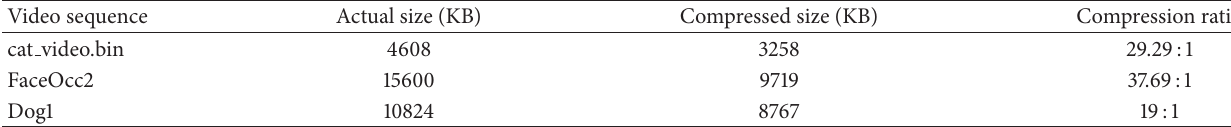
Table 1: Compression ratio of proposed method on various sequences.